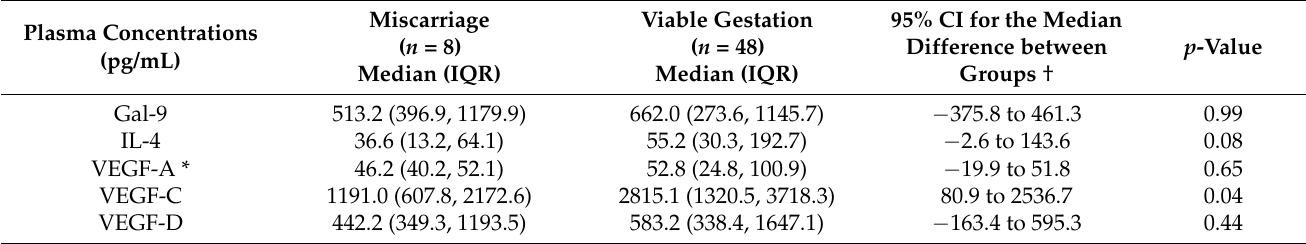
Table 2. Plasma concentrations for immune tolerance markers and angiogenic factors based on pregnancy outcome at 12 weeks